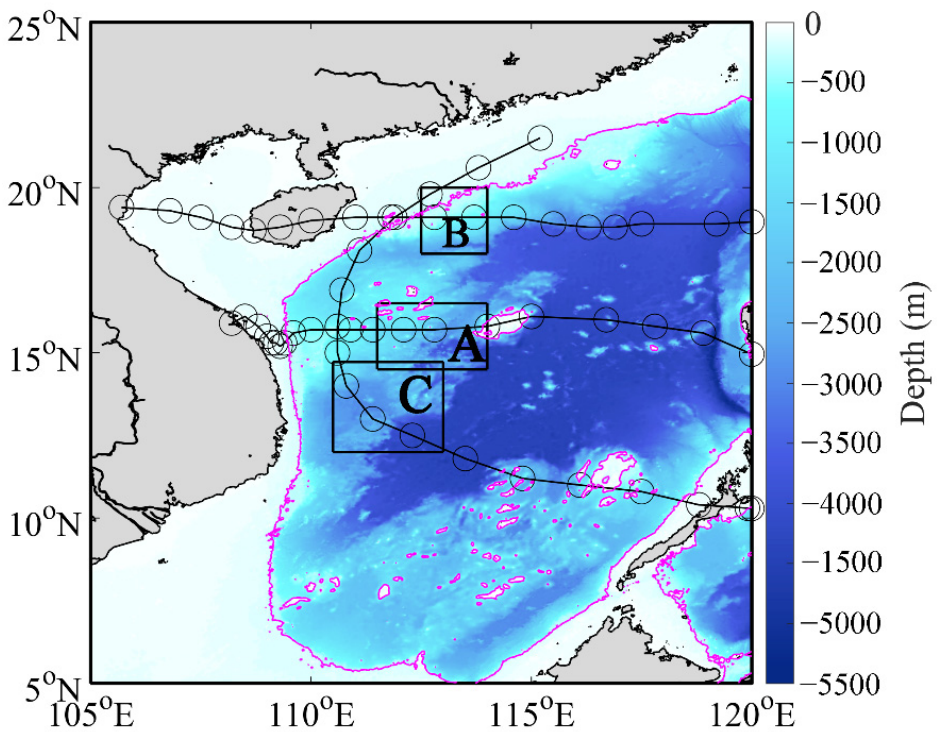
Figure 1. Depth map of the SCS. The black box A represented the selected study area (111.5–114°E, 14.5–16.5°N) of STS “Conson”; The black box B represented the selected study area (112.5–114°E, 18–20°N) of TY “Kompasu”; The black box C represented the selected study area (110.5–113°E, 12–14.725°N) of STY “Rai”. The pink line represented the 200 m isobath; the black circle represented the location of the tropical cyclones every 6 h; the black line represented the path of the tropical cyclones.